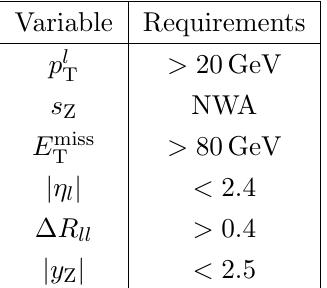
Table 4 . Selections considered in our computations (BL-selections), where l = e; (cid:22) . Additional selection requirements are considered in experiments to improve the signal feasibility. Their e(cid:11)ects are included through an Ancillary A (cid:15) . (cid:1)